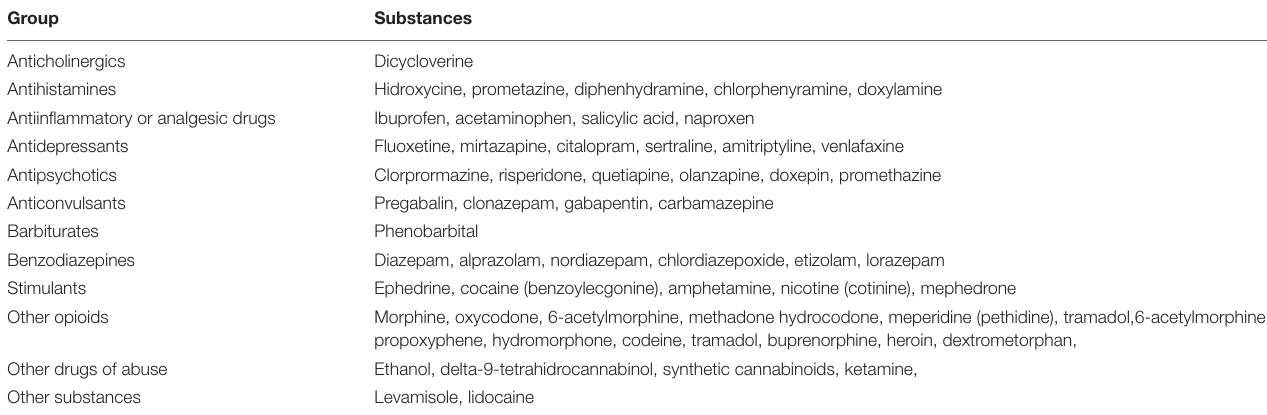
TABLE 1 | Other substances involved in new synthetic opioid overdoses, taking into account the published cases of intoxication (Hull et al., 2007; Lee et al., 2016; McIntyre et al., 2017; Zawilska,